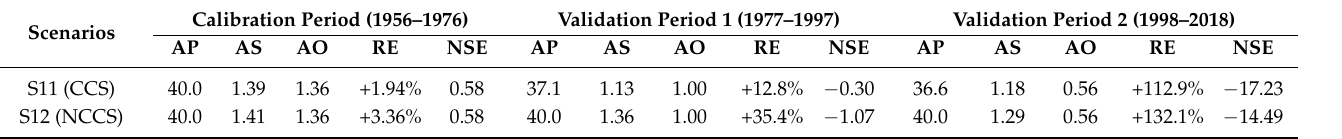
Figure 11. Simulated results of S1 (NCCS). Table 5. Simulated results of